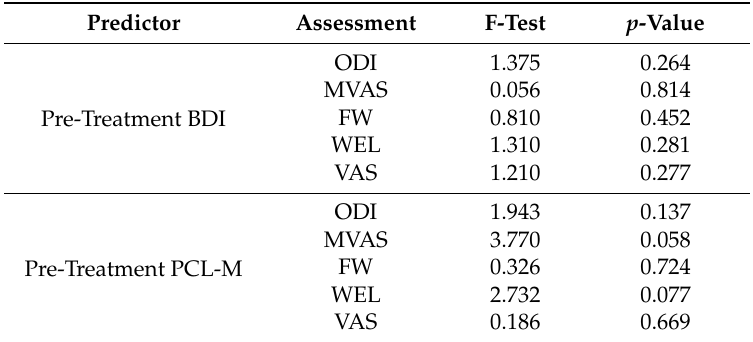
Table 3. General linear model (GLM) of PTSD predicting post-treatment self-report disability (controlling for pre-treatment disability